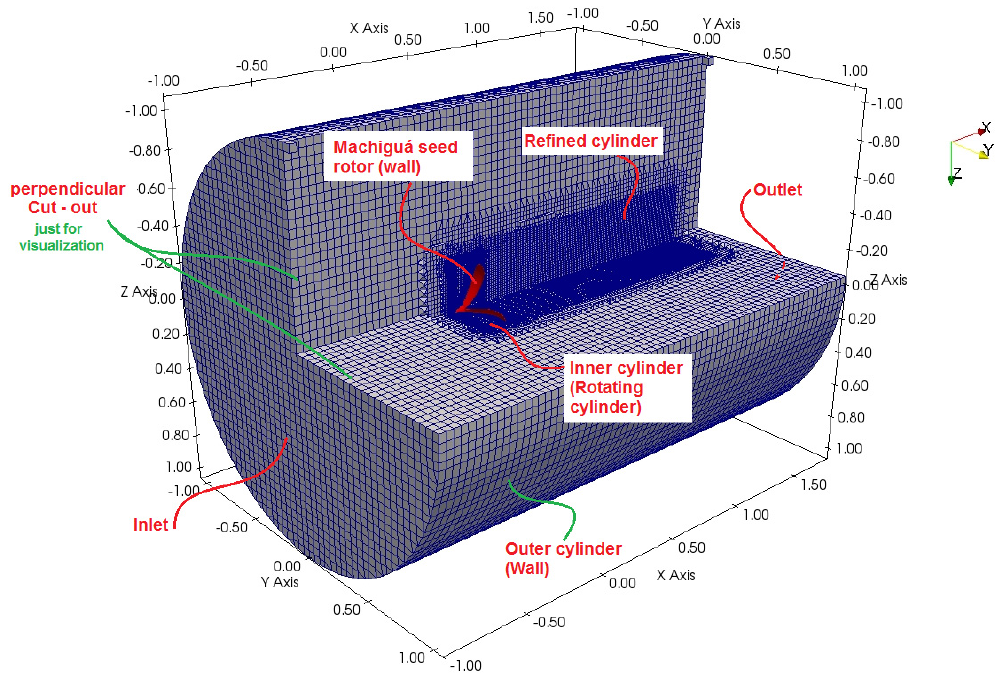
Figure 9. Computational Domain for Machiguá wind rotor.